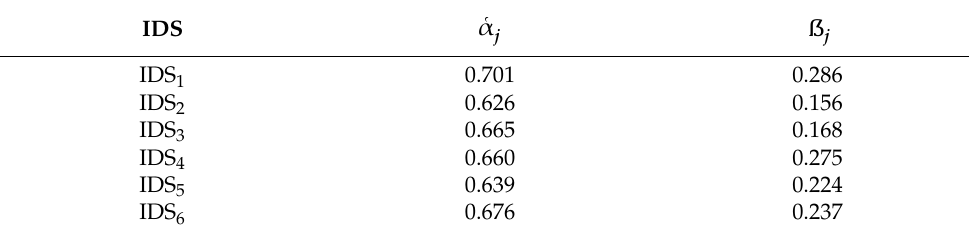
Table 15. The score values of the IDSs for